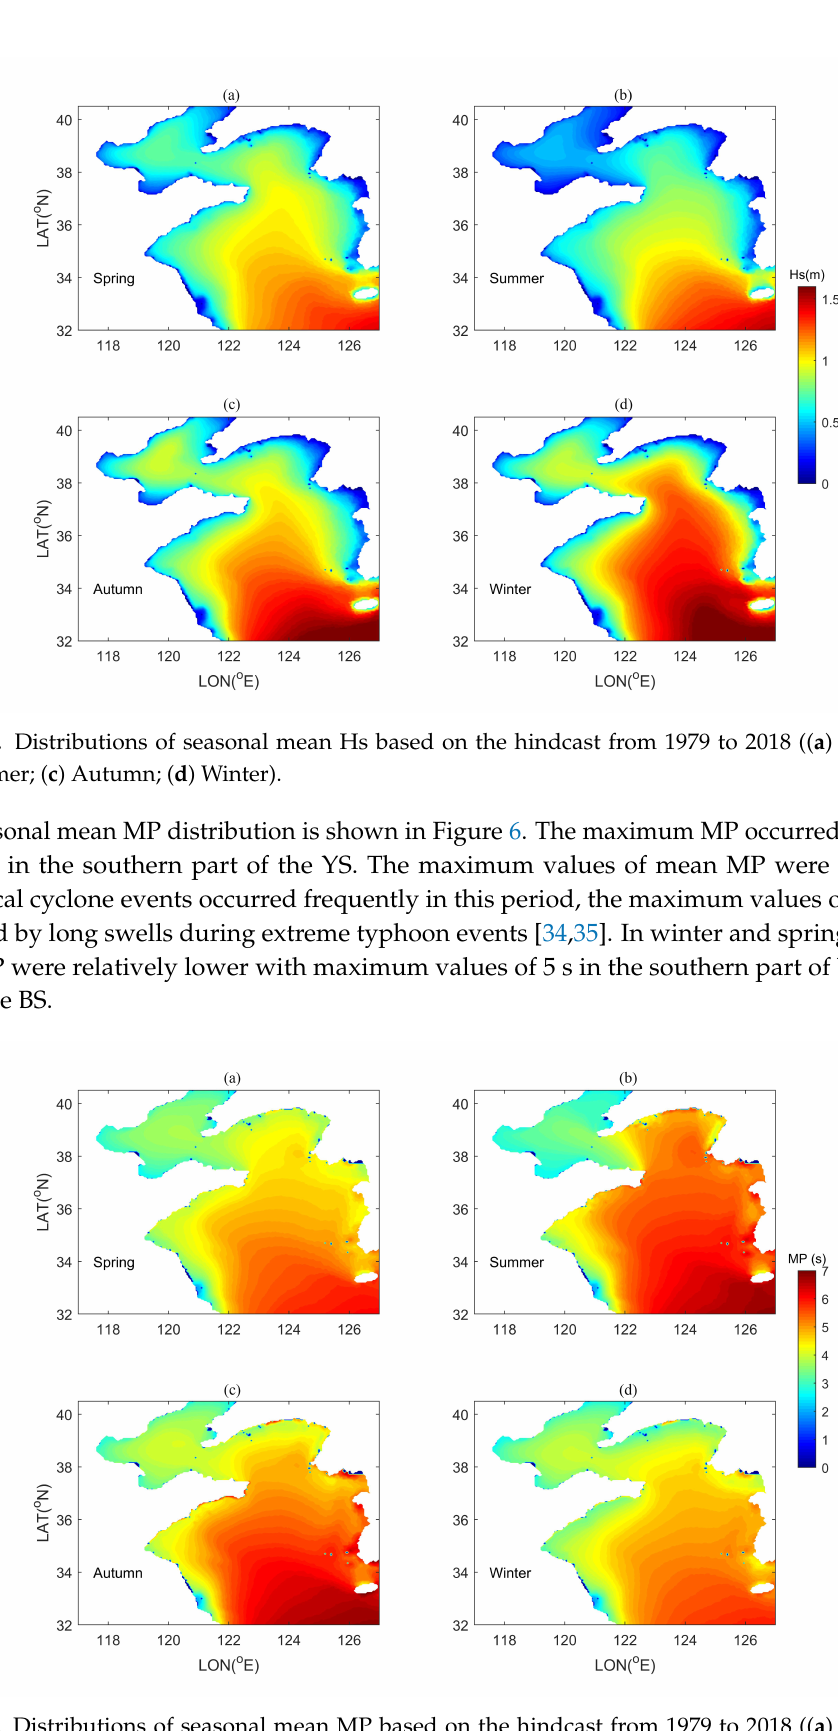
Figure 6. Distributions of seasonal mean MP based on the hindcast from 1979 to 2018 (( a ) Spring; ( b ) Summer; ( c ) Autumn; ( d )